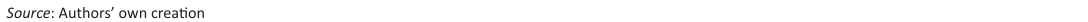
FIGURE 1: The Ndumo Game Reserve, KwaZulu-Natal, South Africa, showing the major pans and rivers that make up the hydrology of the